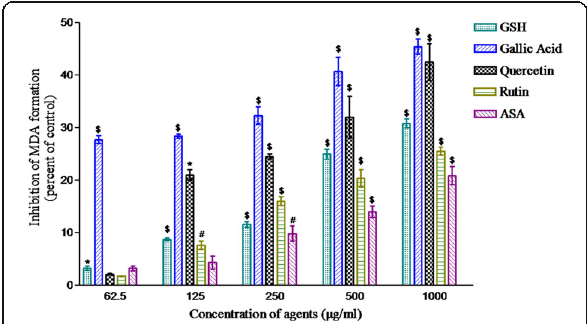
Fig. 4 Peroxidative damage; inhibition in the formation of MDA (nmole MDA/mg of protein) against Fenton reagent. Reduced glutathione, gallic acid, quercetin, rutin, vanillin and acetylsalicylic acid were added at 62.5 – 1000 μ g/ml. The test tubes were incubated for four hours at 37 ° C followed by two consecutive centrifugations. The resulting microsome was used for peroxidative damage estimation. Reduced glutathione was used as a positive control. Values are represented as mean±SEM of three samples. * ( p <0.05), # ( p <0.01) and § ( p <0.001) represent significant